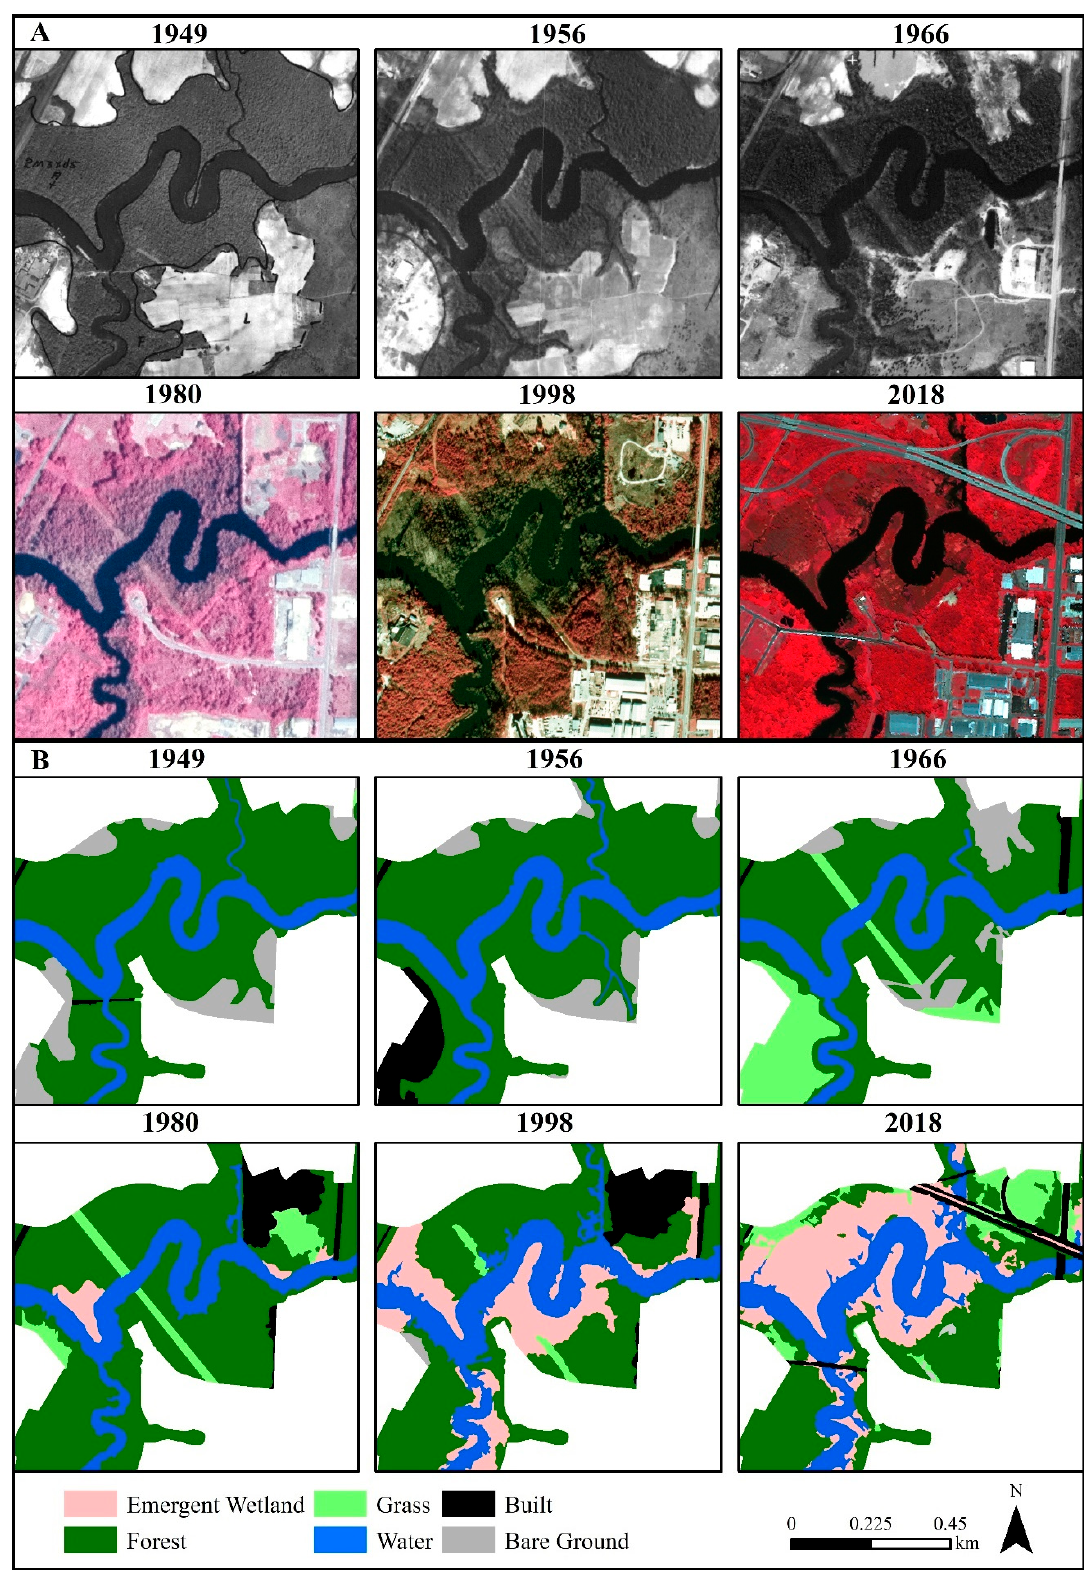
Figure 4. Aerial photography and WorldView-2 imagery for a portion of Smith Creek where ( A ) is aerial photography from 1949 to 1998 and WorldView-2 from 2018 and ( B ) is classified land cover from 1949 to 2018.